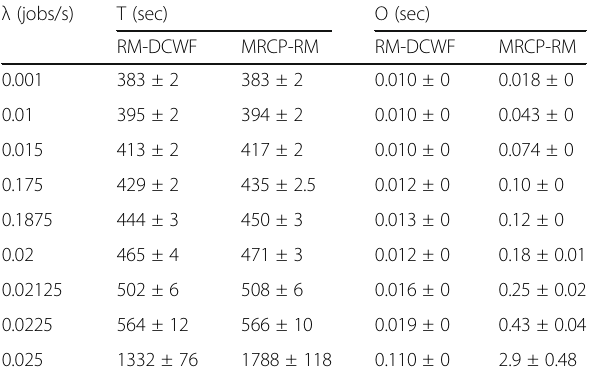
Table 10 RM-DCWF vs MRCP-RM: effect of λ on T and